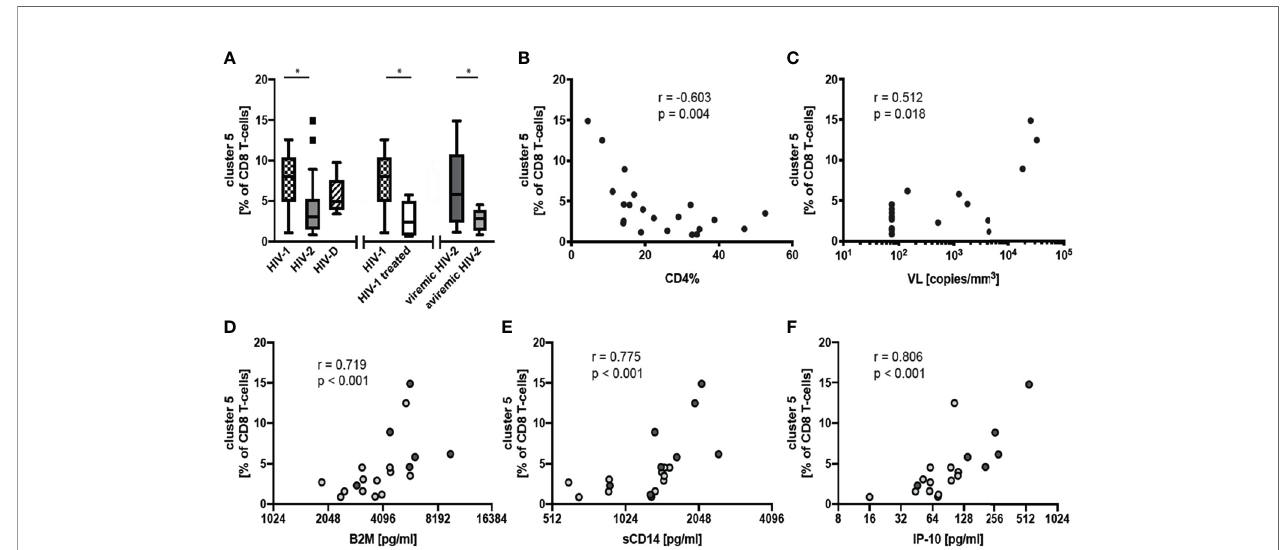
FIGURE 2 | Frequencies of FlowSOM identi fi ed CD8 T-cell cluster 5 in HIV-1, HIV-2 and dually HIV-1/2 (HIV-D) infected individuals. (A) Tukey box plots of frequencies of CD8 T-cell cluster 5 comparing i) treatment naïve or unsuccessfully treated HIV-1 (n = 11), HIV-2 (n = 21) and HIV-D (n = 5), ii) successfully treated HIV-1 (n = 8) and treatment naïve or unsuccessfully treated HIV-1 (n = 11), iii) viremic (n = 9) and treatment-naïve aviremic (n = 14) HIV-2-infected individuals. Differences between two and three groups were determined with Mann-Whitney and Kruskal-Wallis with Dunn´s post-test, respectively. Correlations between frequency of cluster 5 in HIV-2-infected individuals and (B) CD4%, (C) plasma viral load (VL), and concentrations of in fl ammatory markers, (D) beta-2 microglobulin (B2M), (E) soluble CD14 (sCD14) and (F) IP-10, in plasma (aviremic lighter circles and viremic darker circles), according to Spearman´s rank correlation. *p <